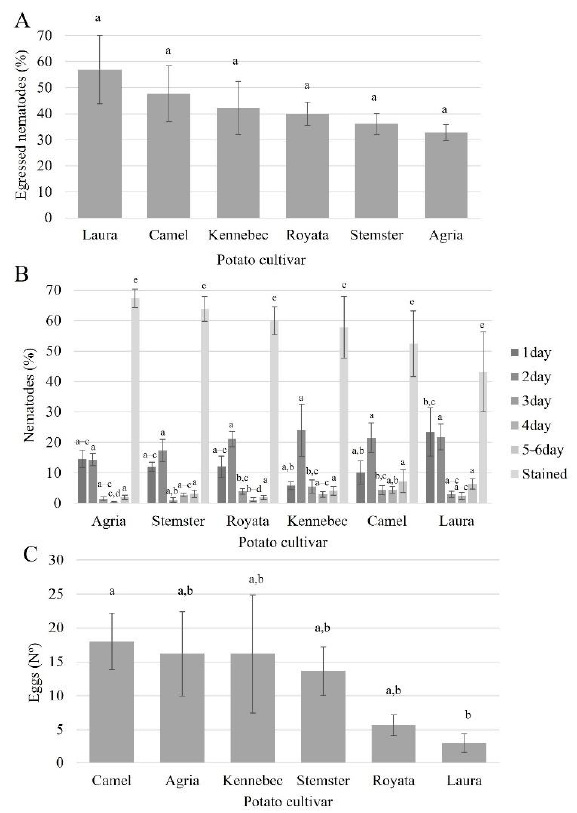
Figure 4. Egression of Pratylenchus penetrans from potato cultivars, Agria, Stemster, Royata, Kennne- bec, Camel, and Laura three days after inoculation with 1000 P. penetrans mixed stages: ( A ) percent- age of total nematodes (mixed stages) egressed; ( B ) egression throughout six days in relation to those that remain inside the root; ( C ) average number of eggs laid by females in stained roots. Data are means of six replicates ± SE. Means followed by different combination of letters differ signifi- cantly at p < 0.05, according to the Fisher LSD test.